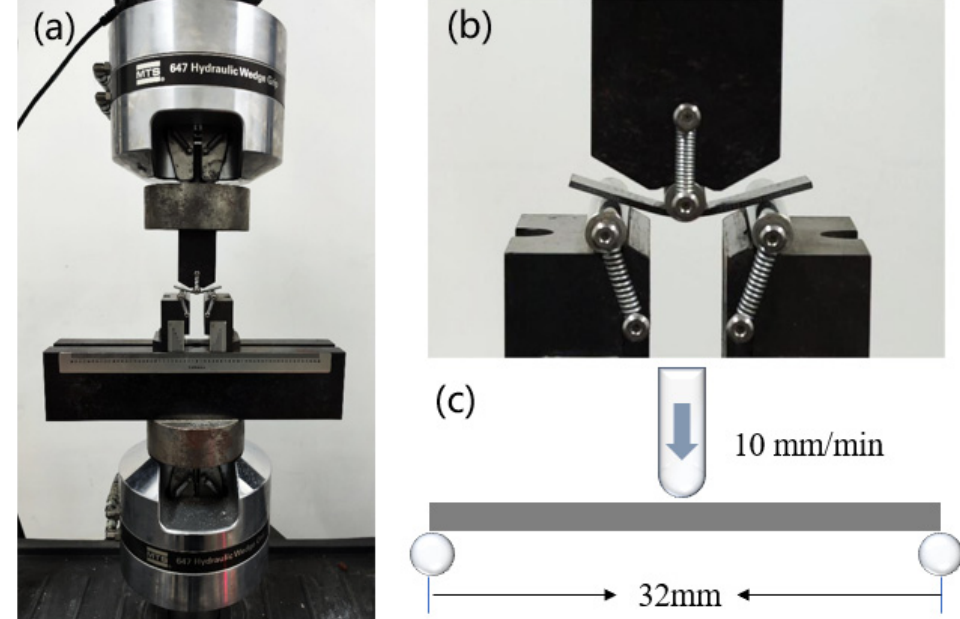
Figure 4. Three-point flexural test diagrams: ( a ) sample under flexural load; ( b ) sample fracture closer view; ( c ) schematic diagram.